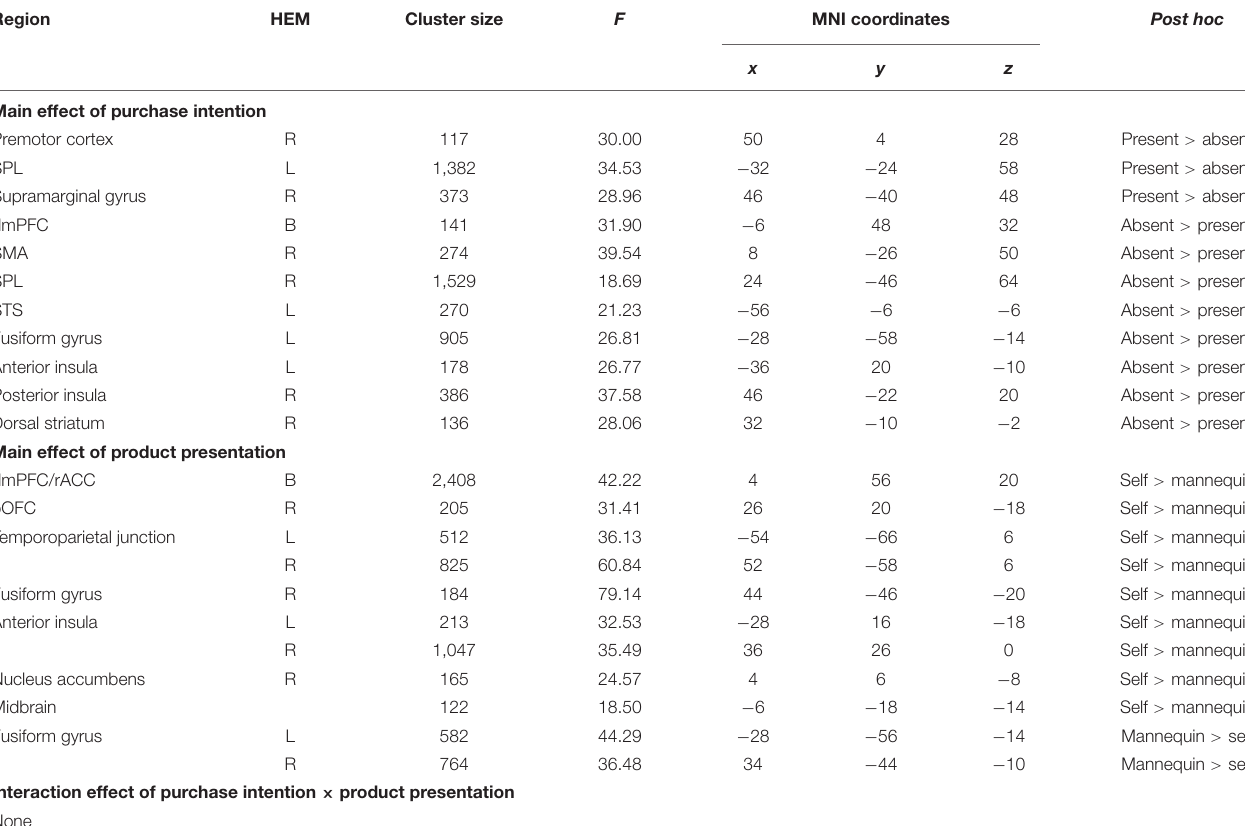
TABLE 3 | Significant brain regions in the mass univariate analysis showing the prediction ability of the imaging data during the fit evaluation phase for purchase intention and product presentation type. Region HEM Cluster size F MNI coordinates